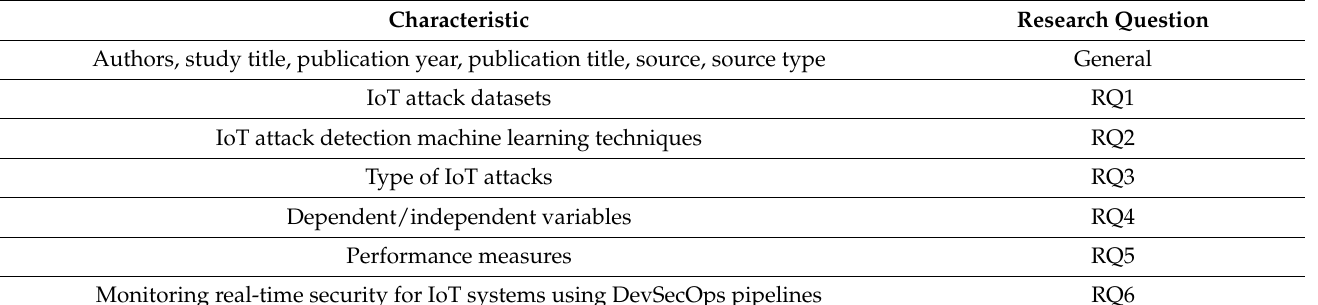
Table 3. Data extraction characteristics related to the research questions.